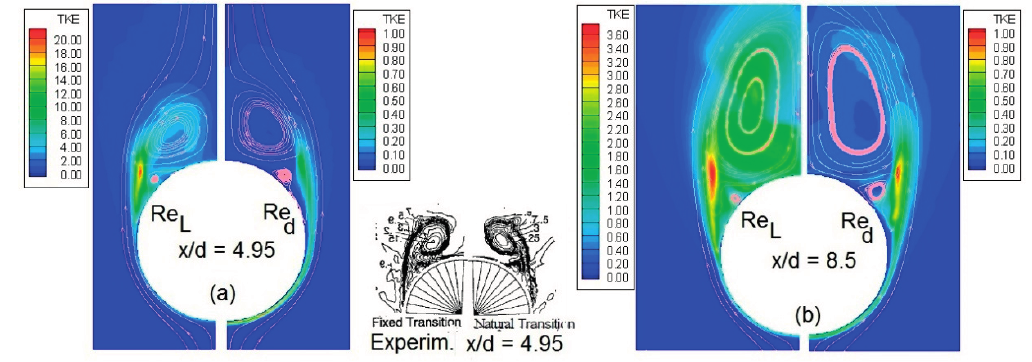
Figure 14. EASM calculations: Turbulent kinetic energy (TKE) distribution in two cross-sections. Calculations using Reynolds number based on length or diameter of body. Inset: experiment, flow visualization by total pressure at cross-section x / d = 4.95